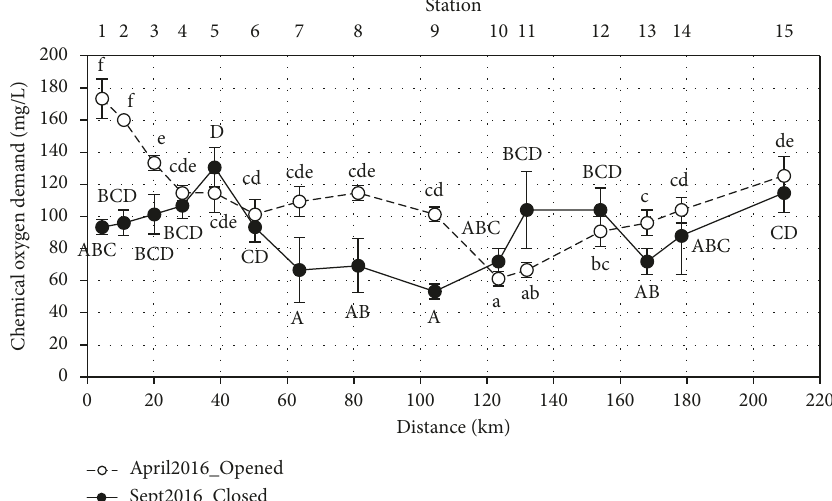
Figure 8: Chemical oxygen demand at the 15 stations downstream of Bakun Hydroelectric Dam during opened spillway ( o ) and closed spillway ( • ). The same letter indicates no significant difference ( p > 0 .